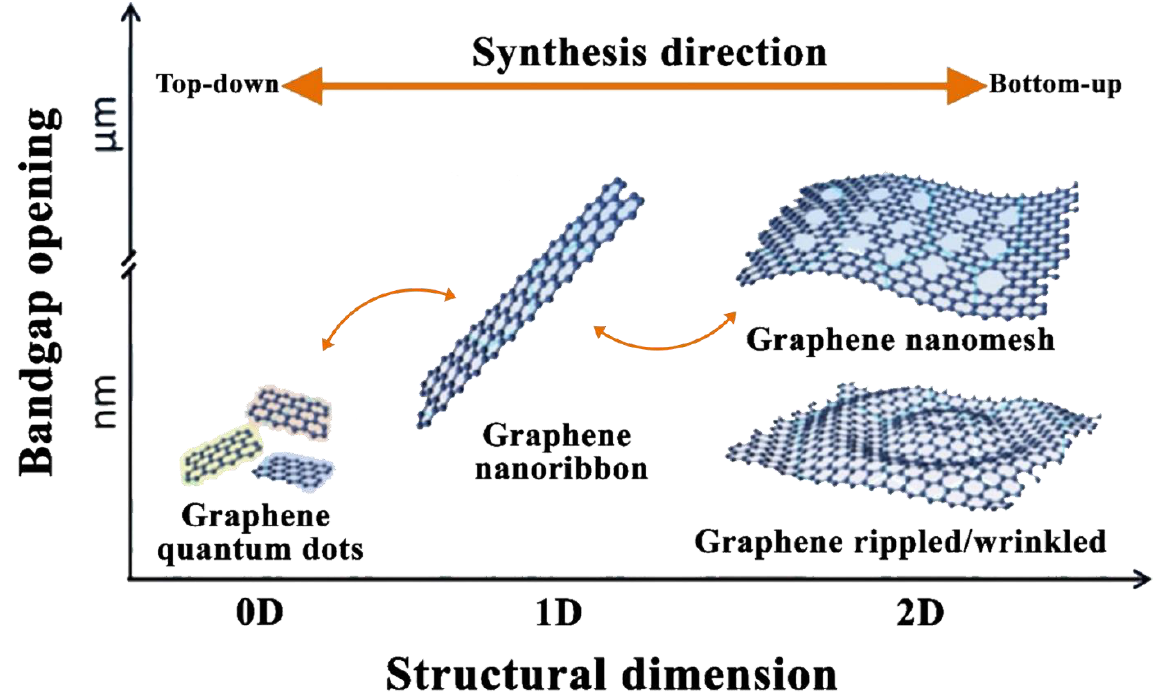
Figure 6. Different forms of graphene based on their dimensionality and bandgap opening, where graphene quantum dots, graphene nanoribbon, and both graphene nanomesh and graphene rippled/wrinkled have a structural dimension of 0D, 1D, and 2D, respectively.